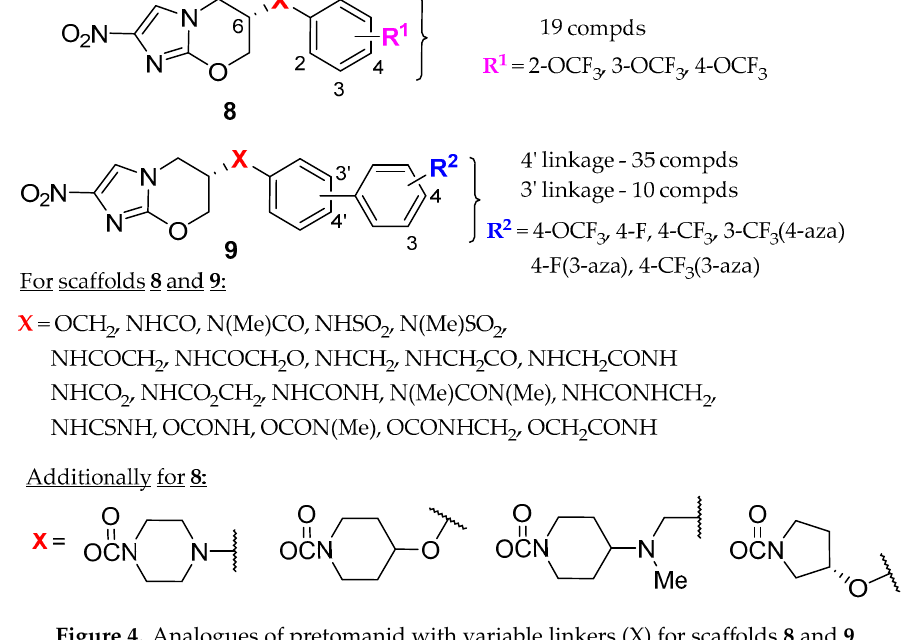
Figure 4. Analogues of pretomanid with variable linkers (X) for scaffolds 8 and 9 .